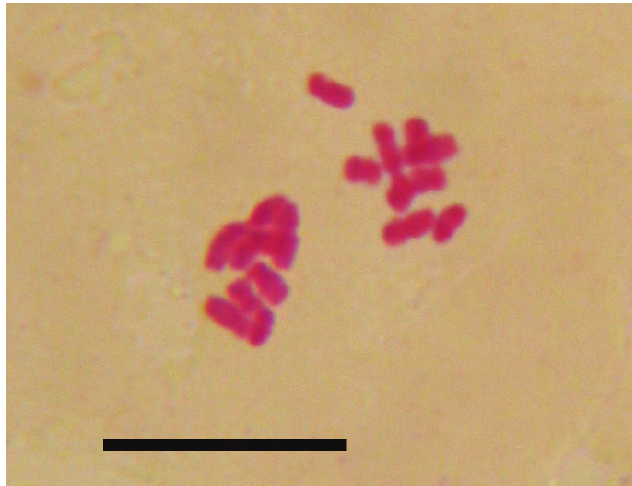
Figure 3. Centaurea ionica Brullo, 2 n = 18. Scale bar: 10 μm.